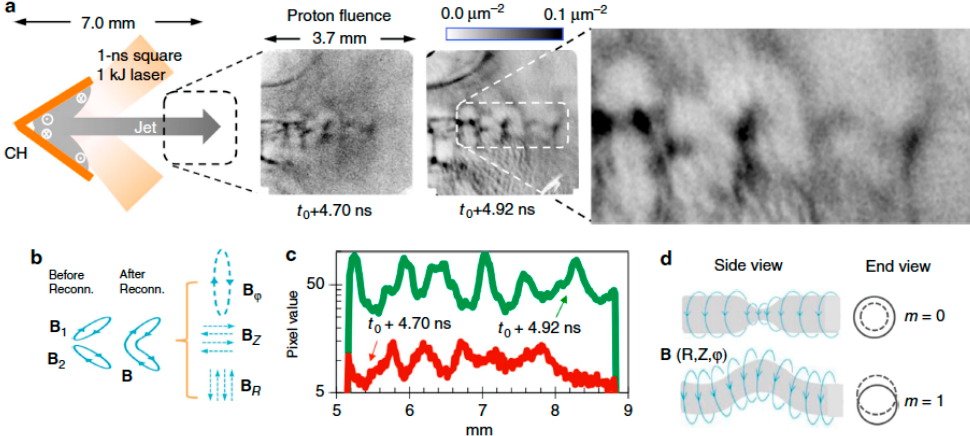
Table 1. Scaled lab experiments (depicted in Figure 3) explain kink behavior of the Crab Nebula jet